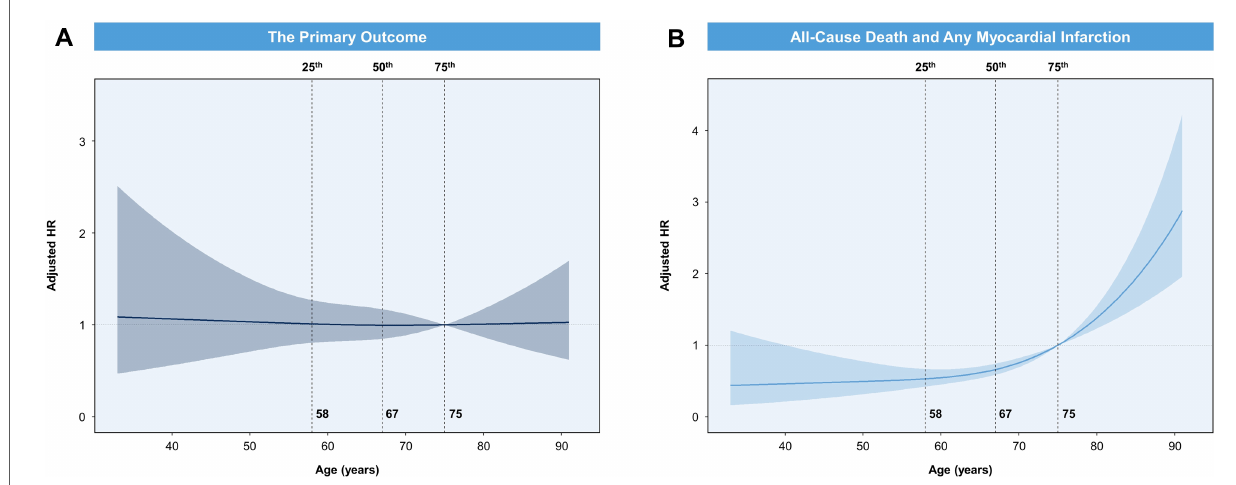
FIGURE 3 ( A ) spline curve for the association of age with the hazard of the primary outcome. ( B ) Spline curve for the association of age with the hazard of combined all-cause death and any myocardial